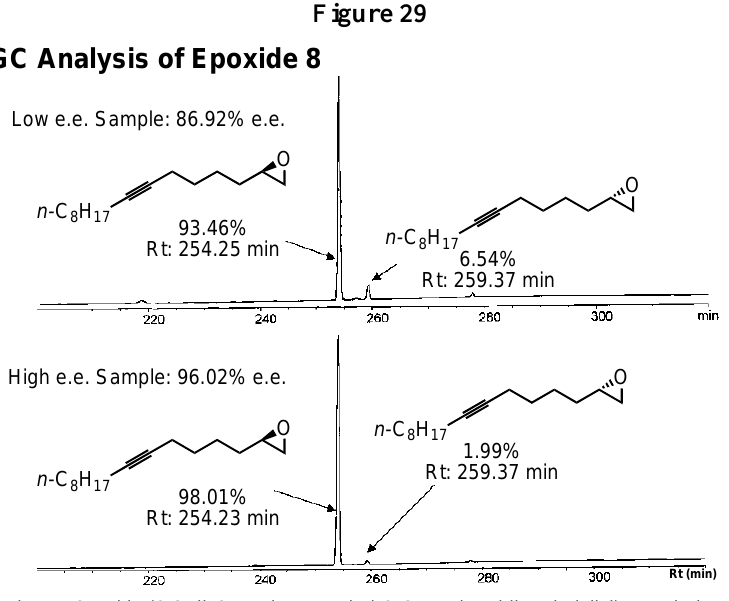
GC Analysis of Epoxide